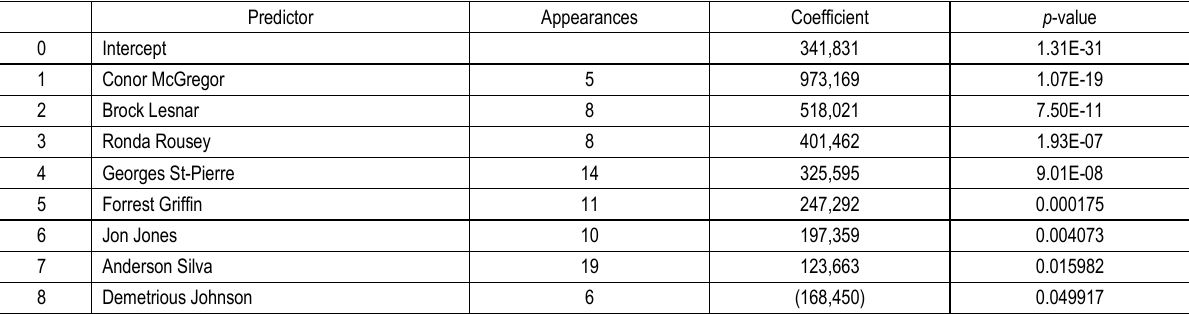
Table 2. Regression model